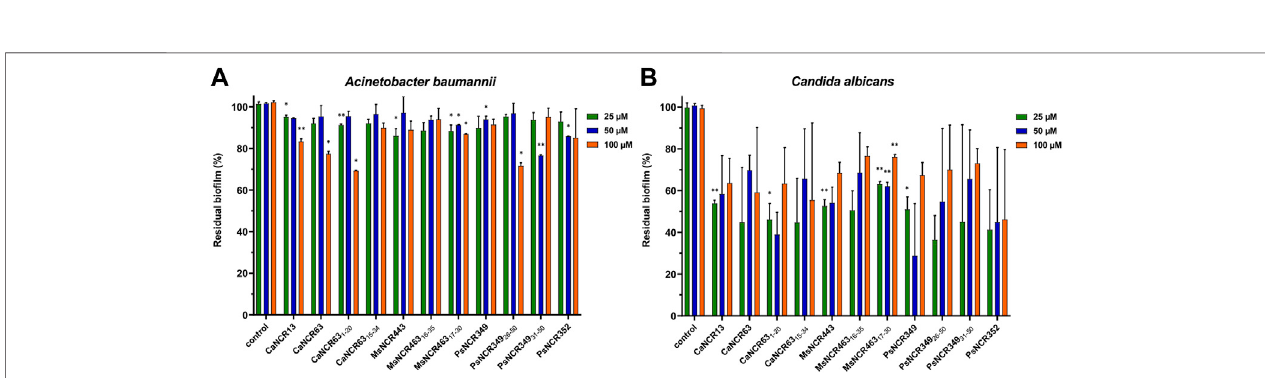
FIGURE2| Effectofthepeptidesonbio fi lmsof (A) A.baumannii and (B) C.albicans .Thequantityofresidualbio fi lmsafterovernighttreatmentwithNCRsat25,50 or 100 μ M compared to the untreated controls. The values are the means of two experiments, the bars indicate SD. *: p < 0.05, **: p < 0.01 as determined by one-way